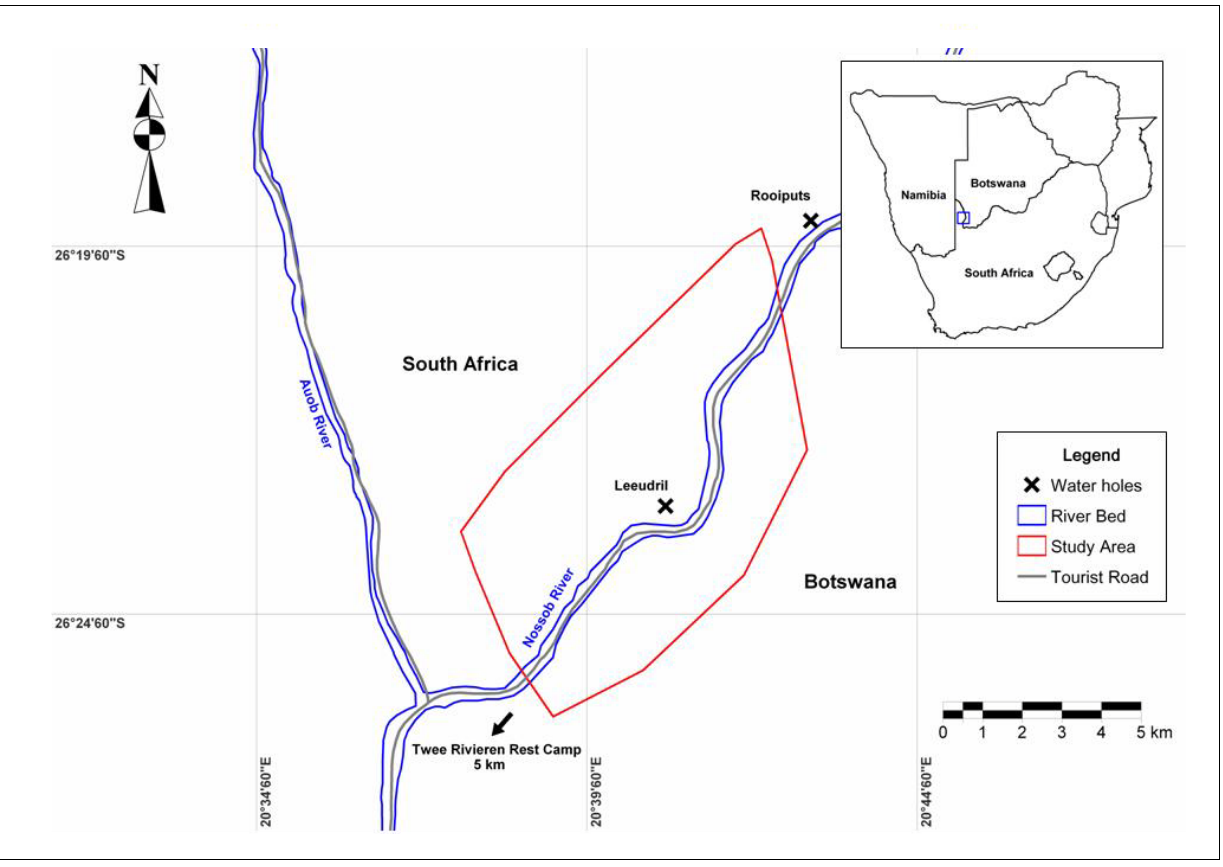
Figure 1 Study site in the Kgalagadi Transfrontier Park, indicating the area around the Nossob riverbed and Leeudril waterhole, where African wildcats, Felis silvestris cafra , were radio collared and